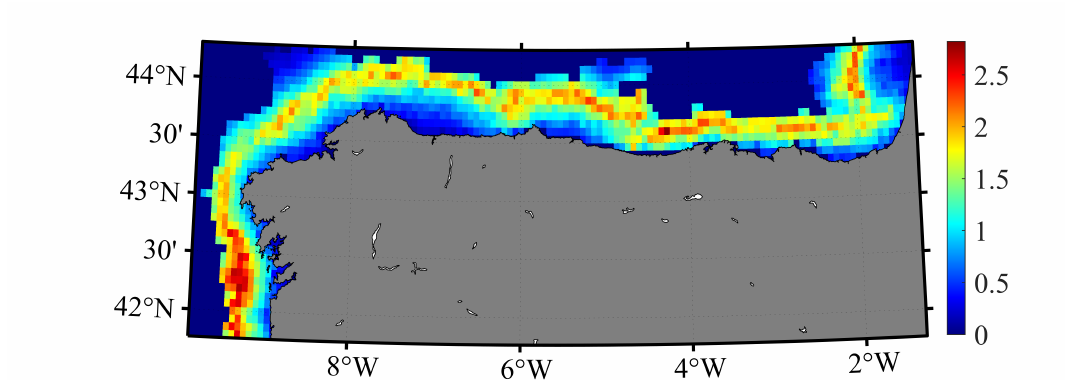
Figure 4. Density of bottlenose dolphins calculated from PELACUS—IEO survey (2007–2017). The color bar represents density of dolphins in a cell grid of (5.5 × 7.7) km 2